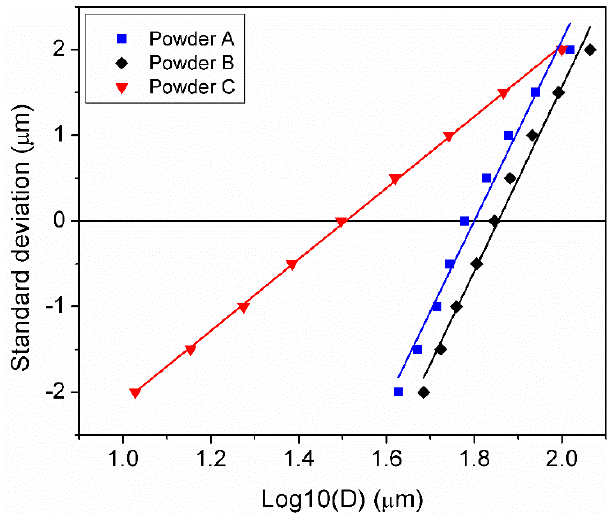
Figure 2. Graphical representation of the cumulative logarithmic particle size versus the standard deviation of powders A, B, and C. Table 1. Particle size distribution of the tested powders A, B, and C.